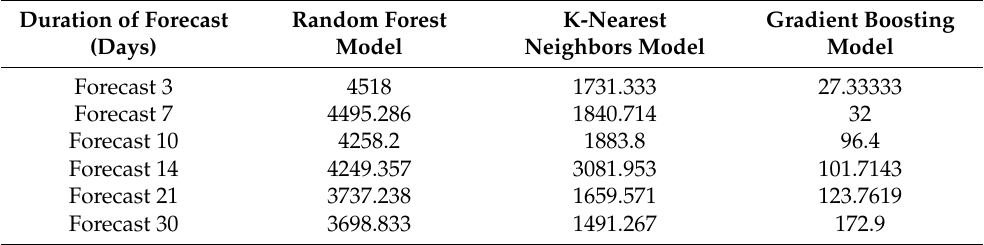
Table 7. Mean absolute error of forecasted cumulative new cases for South Korea (number of cases).